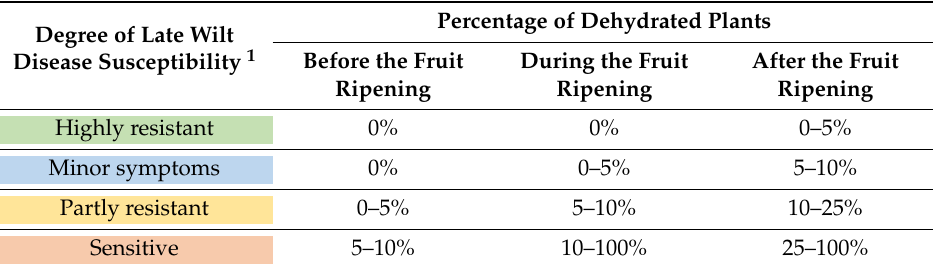
Table 2. Classification of maize cultivars according to late wilt disease